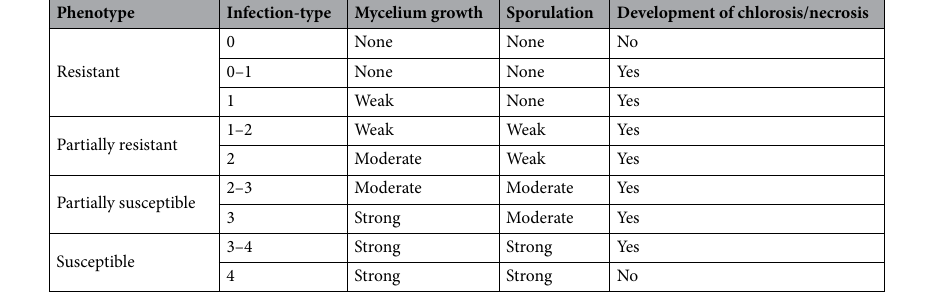
Nucleotide-binding leucine-rich repeat proteins in powdery mildew resistance-associated blocks on chromosome arm 7RL. Annotation of NLR genes in the reference genomes ‘Lo7’ and ‘Wein- ing’ led to the identification of 770 and 1027 full-length (‘complete’) NLR genes, respectively. Positional informa- tion, annotation, and NB-ARC and NLR sequences of all ‘complete’ and ‘partial’ NLR genes for both reference genomes have been made available at https:// doi. org/ 10. 5281/ zenodo. 50858 54. The PM resistance-associated